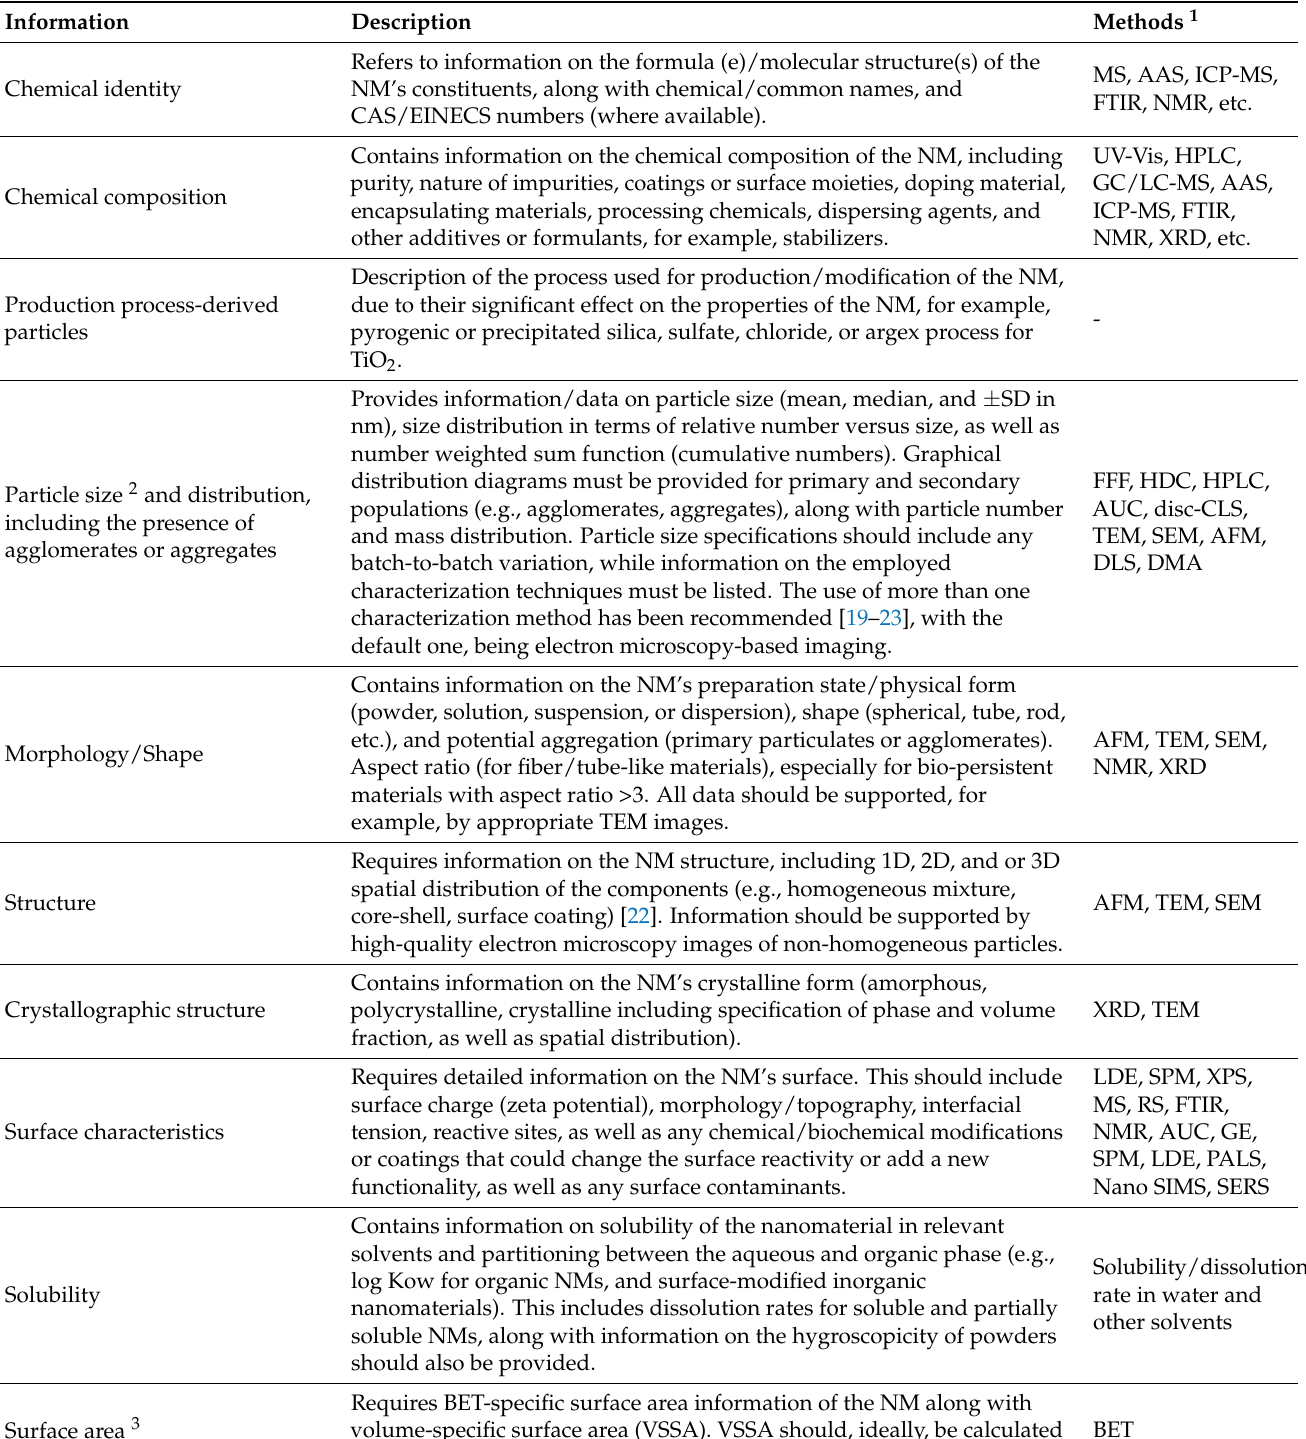
Table 2. Checklist of required physicochemical characteristics of NM intended for use in cosmetic products